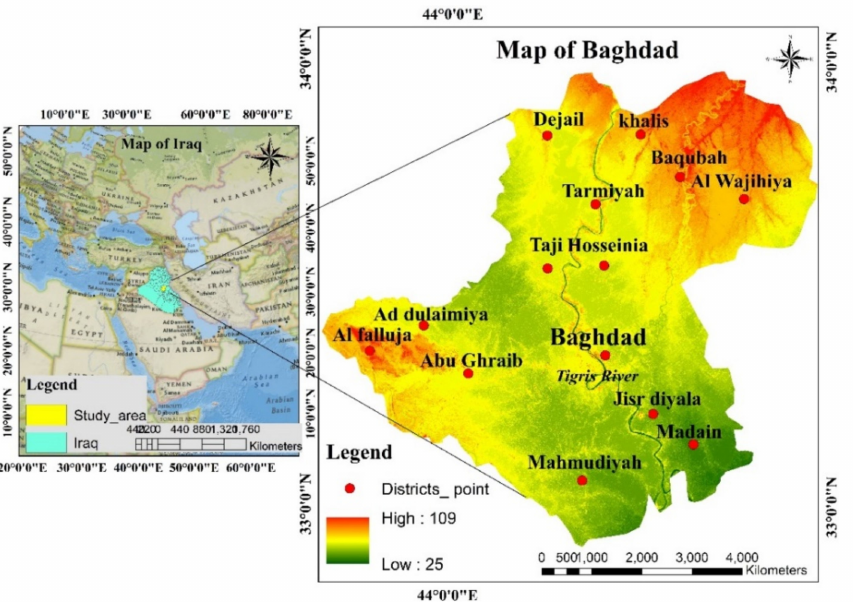
Figure 1. Location of the study area of Baghdad; Location of Iraq and the map of the study area highlights in the left panel. The right panel shows the Digital Elevation Model (in meters) with important district location points highlights in red